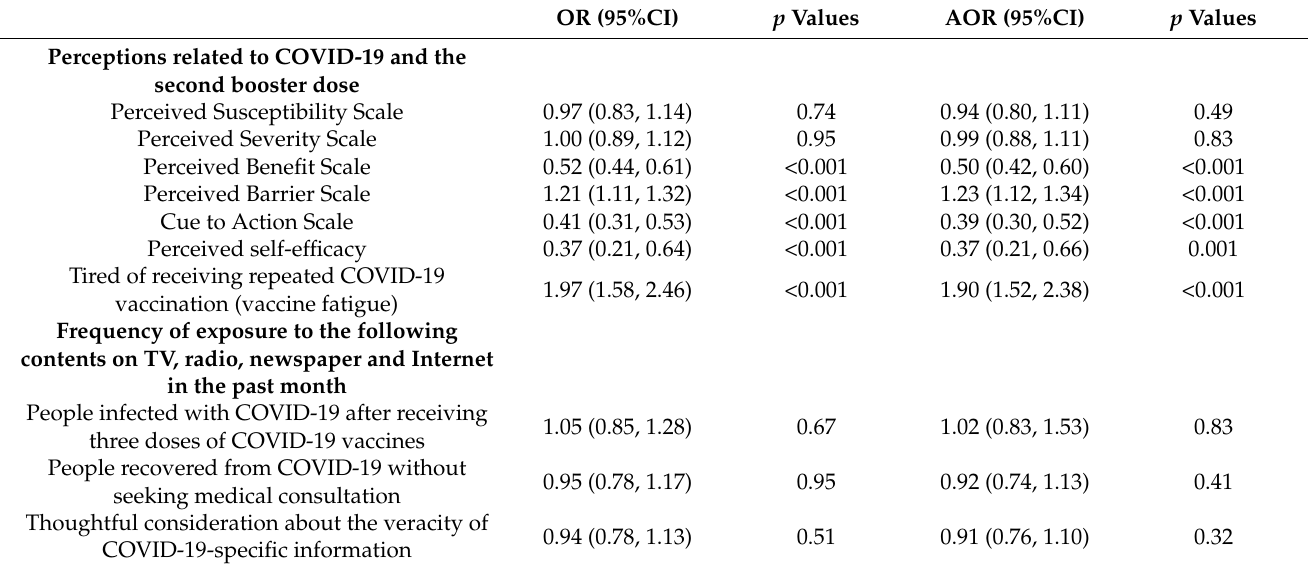
Table 4. Factors associated with hesitancy to receive the second COVID-19 vaccine booster dose. OR (95%CI) p